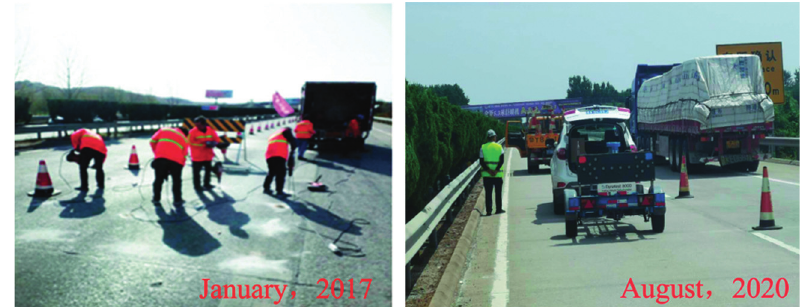
Figure 16: Grouting repair and deflection test.